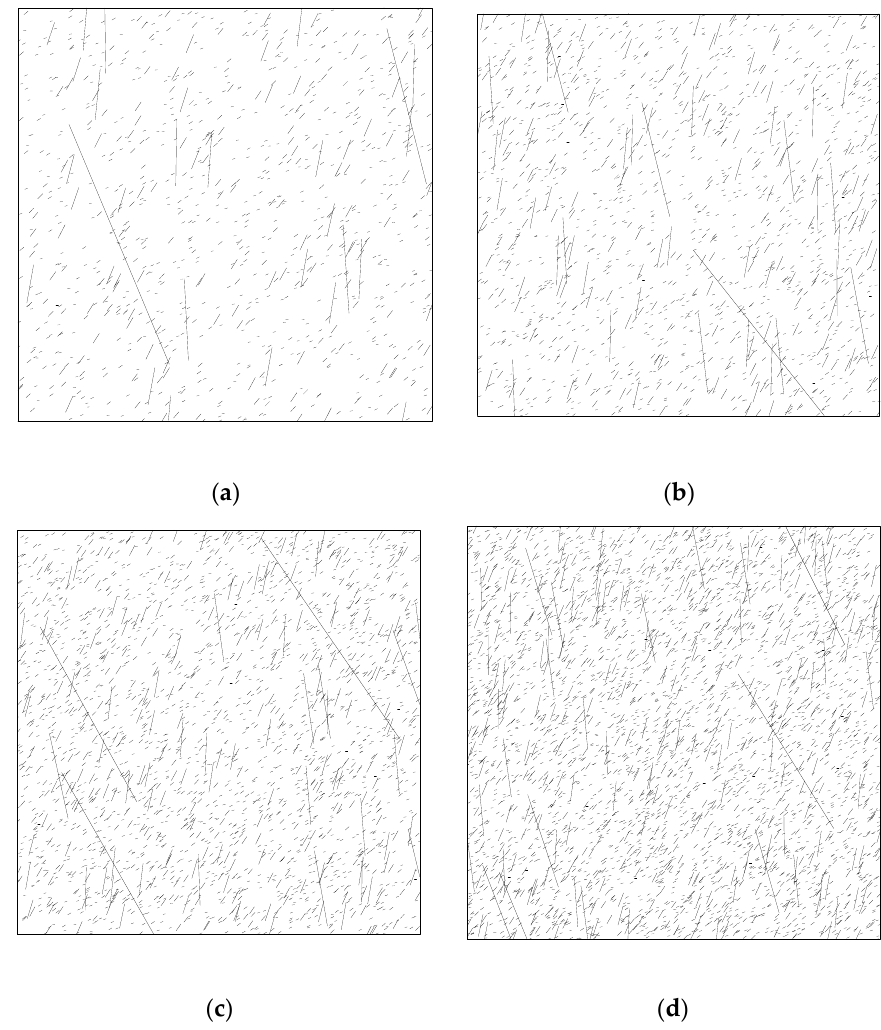
Figure 1. Four fractal discrete fracture networks with different fractal dimensions: ( a ) fractal length dimension D l = 1.5, and total fracture number N t = 1000; ( b ) fractal length dimension D l = 1.6, and total fracture number N t = 1585; ( c ) fractal length dimension D l = 1.7, and total fracture number N t = 2512; ( d ) fractal length dimension D l = 1.8, and total fracture number N t =